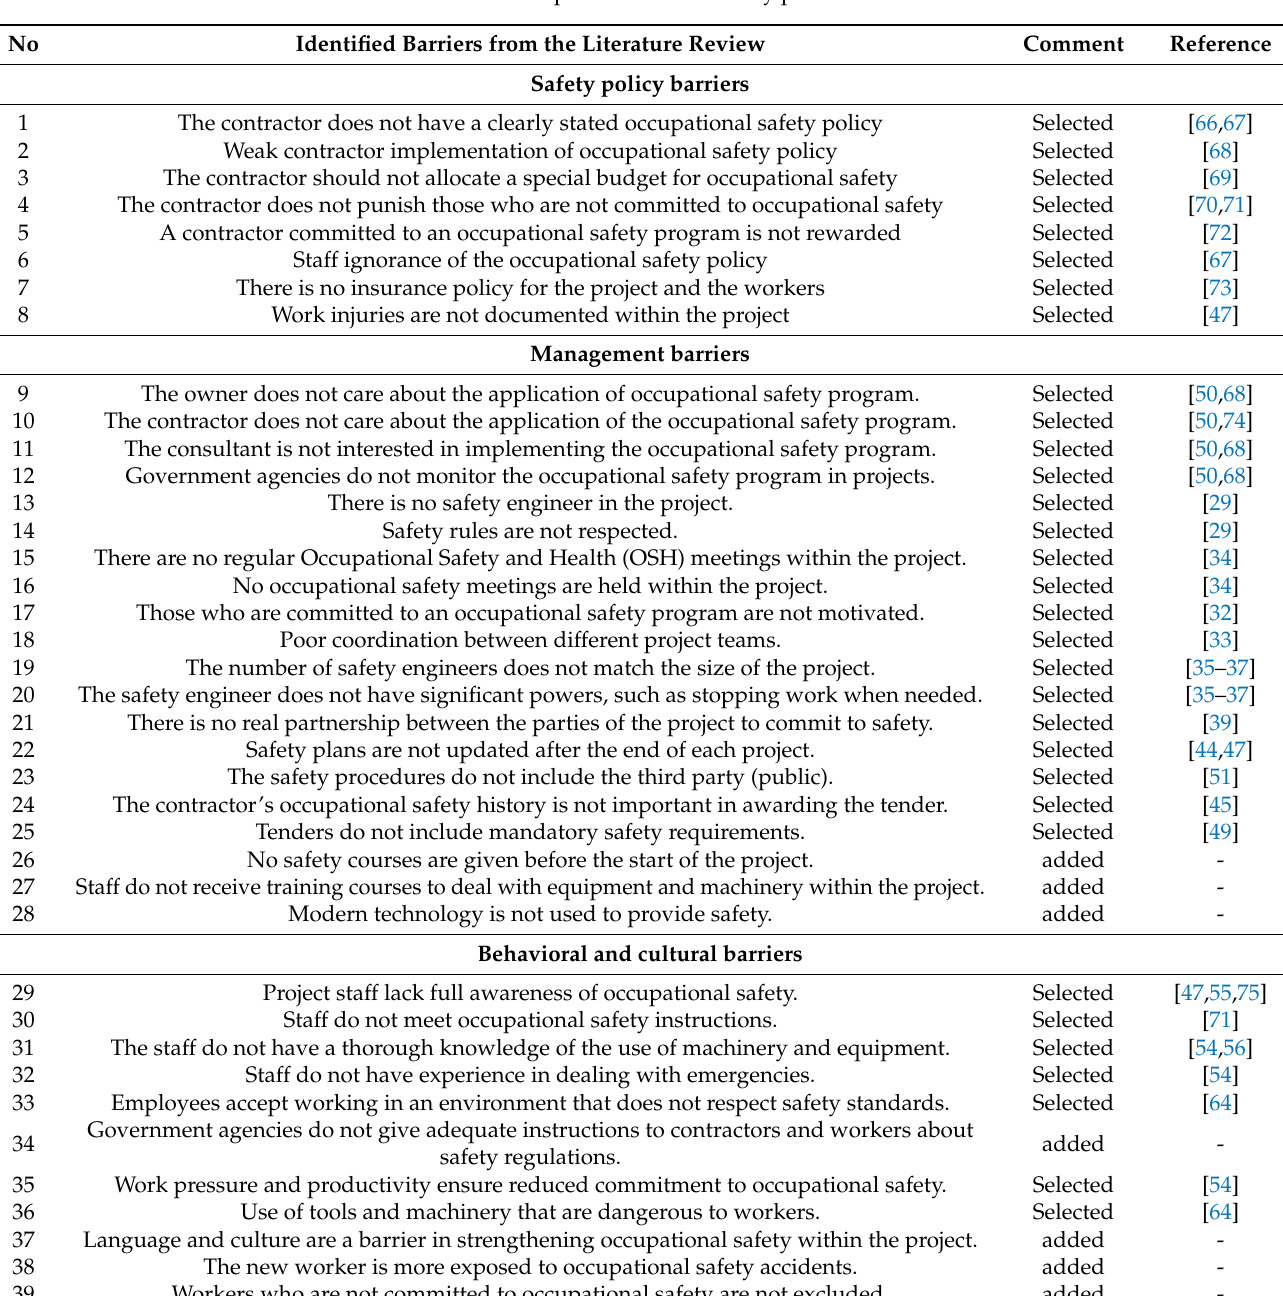
Table 1. List of barriers that hinder the implementation of safety practices in the infrastructure